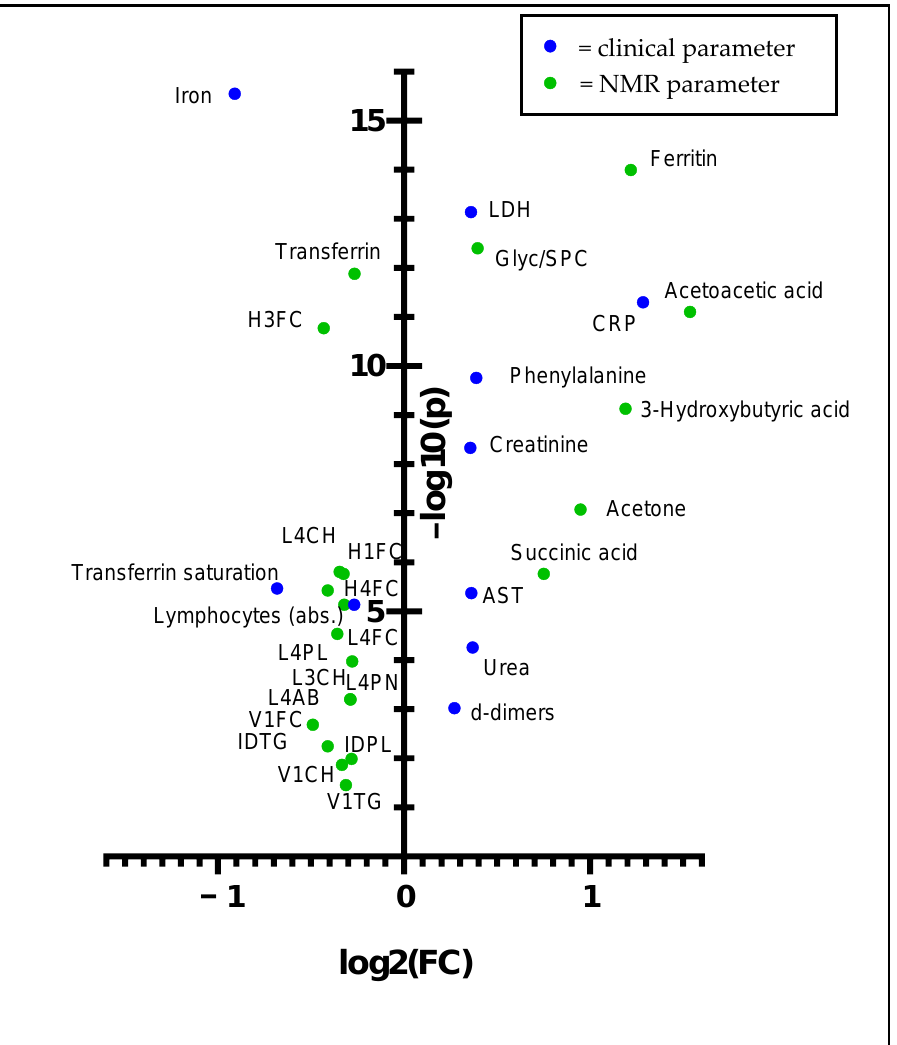
Figure 4. Volcano plot (FDR p < 0.05) showing the univariate analysis of the patients who were admitted to the hospital with patients who stayed confined at home. Blue dots indicate clinical parameters, whereas green dots represent IVDr-based NMR